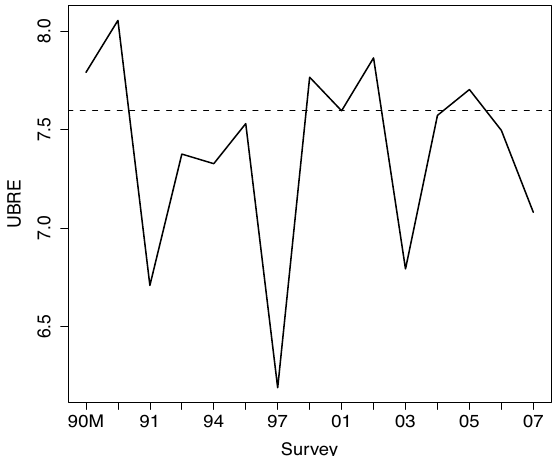
Fig . 6. – Sensitivity to surveys. Un-biased risk estimator (UBRE) scores of the final model when each survey (x-axis) is excluded from the model fitting. The horizontal dashed line is the UBRE score of the final model when all the surveys are used.